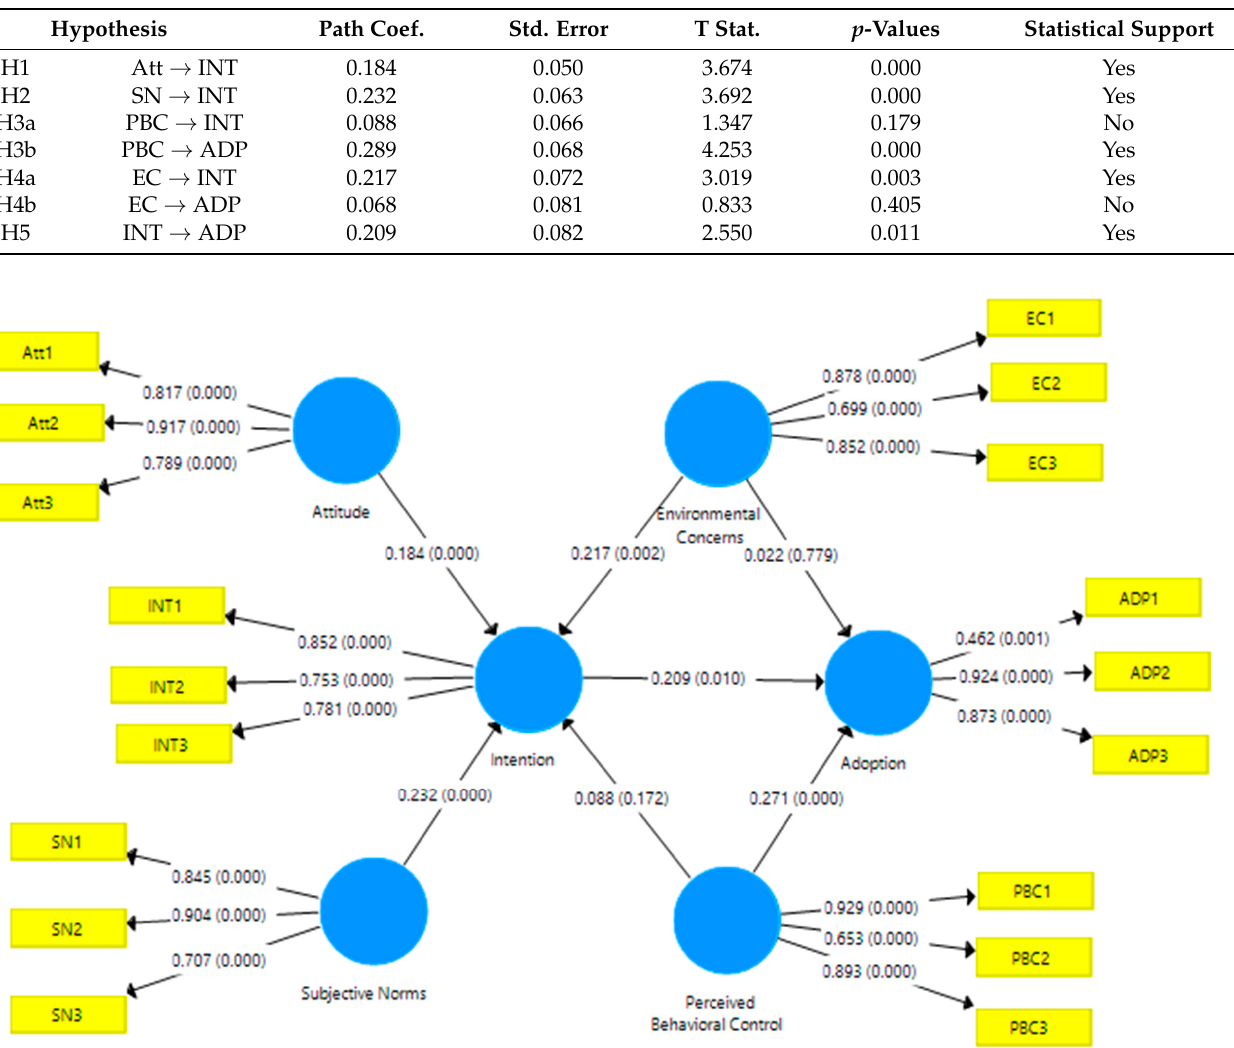
Table 5. Result of the structural model.